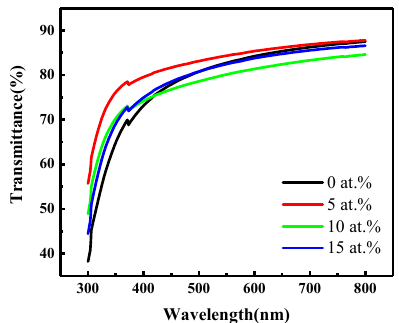
Figure 3. Optical transmittance spectrum of SnO 2 :Si films with different doping concentrations.